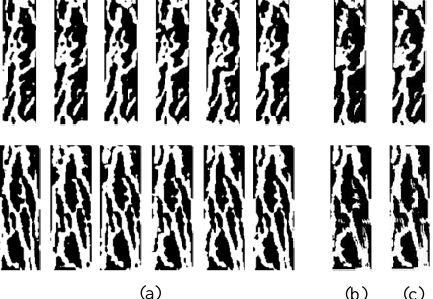
Figure 10. The results for template generation. ( a ) enrollment samples; ( b ) templates generated by the average approach; ( c ) template generated by the weight average approach. (Samples in the first row are from the HKPU Database and samples in the second row are from the FV-USM Database).